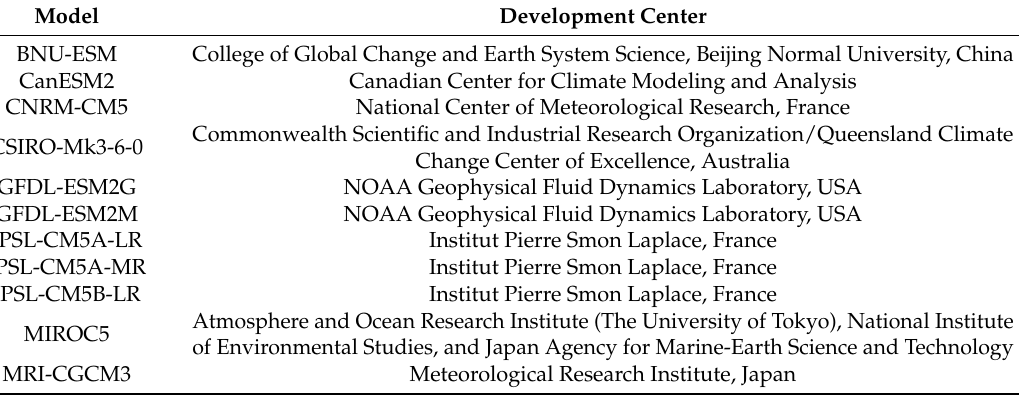
Table 1. The CMIP5 models used in this study for downscaled climate data and the model development